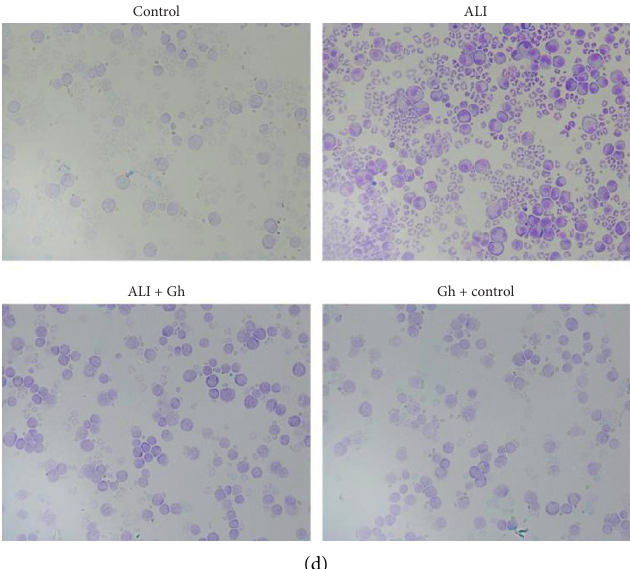
Figure 3: Ghrelin pretreatment reduced inflammation in the BALF of LPS-induced ALI rats. The levels of (a) TNF- α and (b) IL-6 as well as (c) the total cell count in the bronchoalveolar lavage fluid (BALF) of the four groups. (d) Giemsa staining of cytospin preparations of BALF for the four groups. ∗ p < 0 . 05 vs. the saline group; # p < 0 . 05 vs. the ALI group. Data are presented as the mean ± SD ( n �